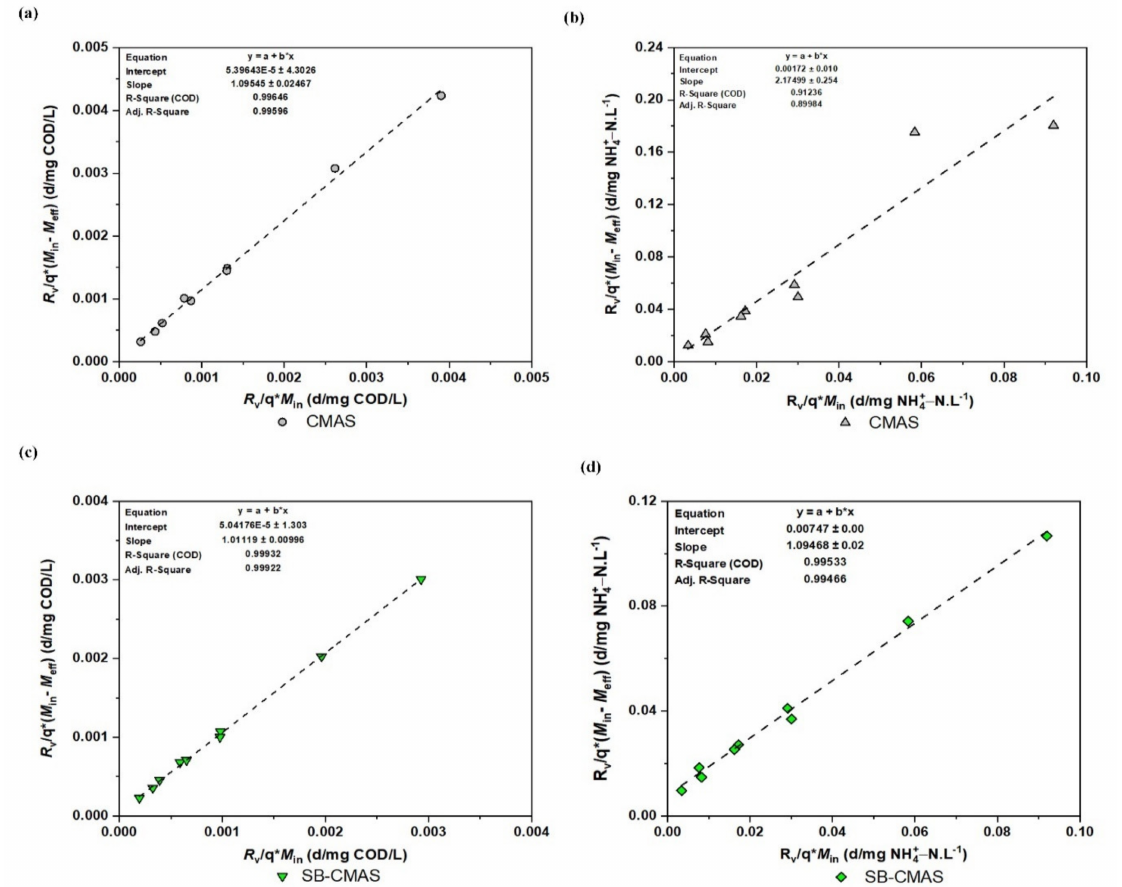
Figure 13. Modified Stover kinetic plot: ( a ) COD for CMAS, ( b ) NH 4+ − N for CMAS, ( c ) COD for SB-CMAS, and ( d ) NH 4+ − N for